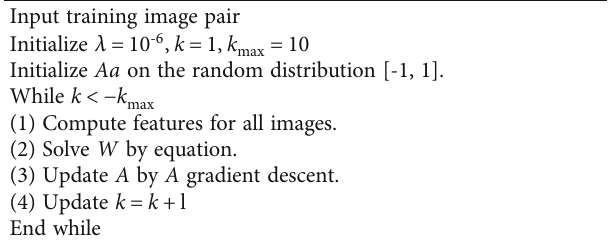
Figure 1: Face detection model based on partial di ff erential equation. Table 1: Partial di ff erential equation face recognition model